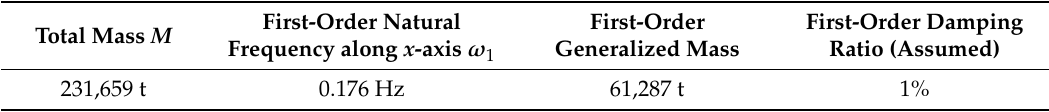
Table 1. Main dynamic parameters of the primary structure.